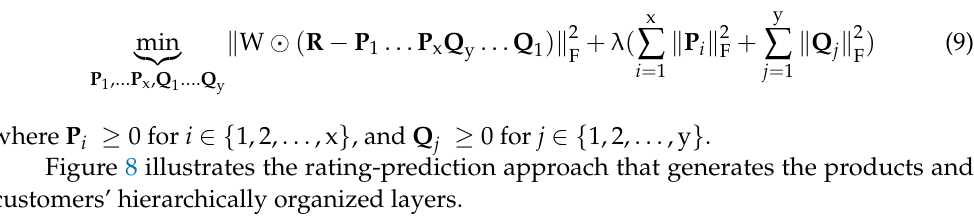
Figure 7. Generating product’s implicit dormant features.